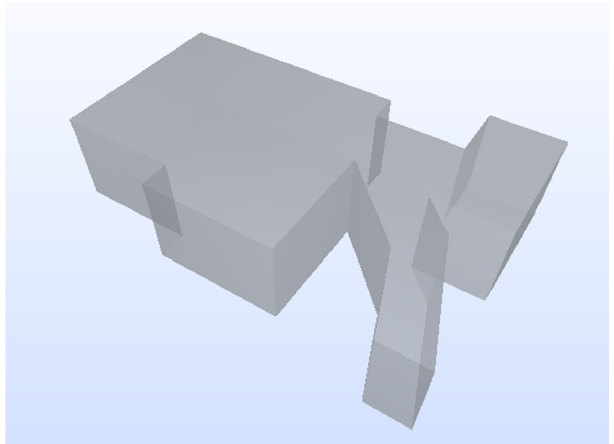
Figure 12 . Conceptual Mass as an IfcSpace object. Figure 12. Conceptual Mass as an IfcSpace